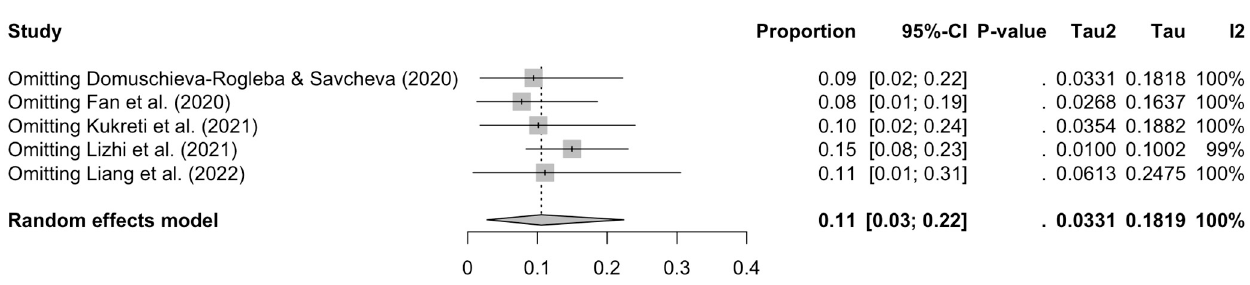
Figure 2. Forest plot for the prevalence of PTSD among teachers [11,25,46–48]. Excluding each study one by one from the analysis did not substantially change the pooled prevalence of PTSD, which varied from between 8% (95% CI: 1–19%), with Fan et al. [11] excluded, and 15% (95% CI: 8–23%), with Lizhi et al. [46] excluded (Figure 3). This indicates that no single study had a disproportional impact on the overall PTSD prevalence.